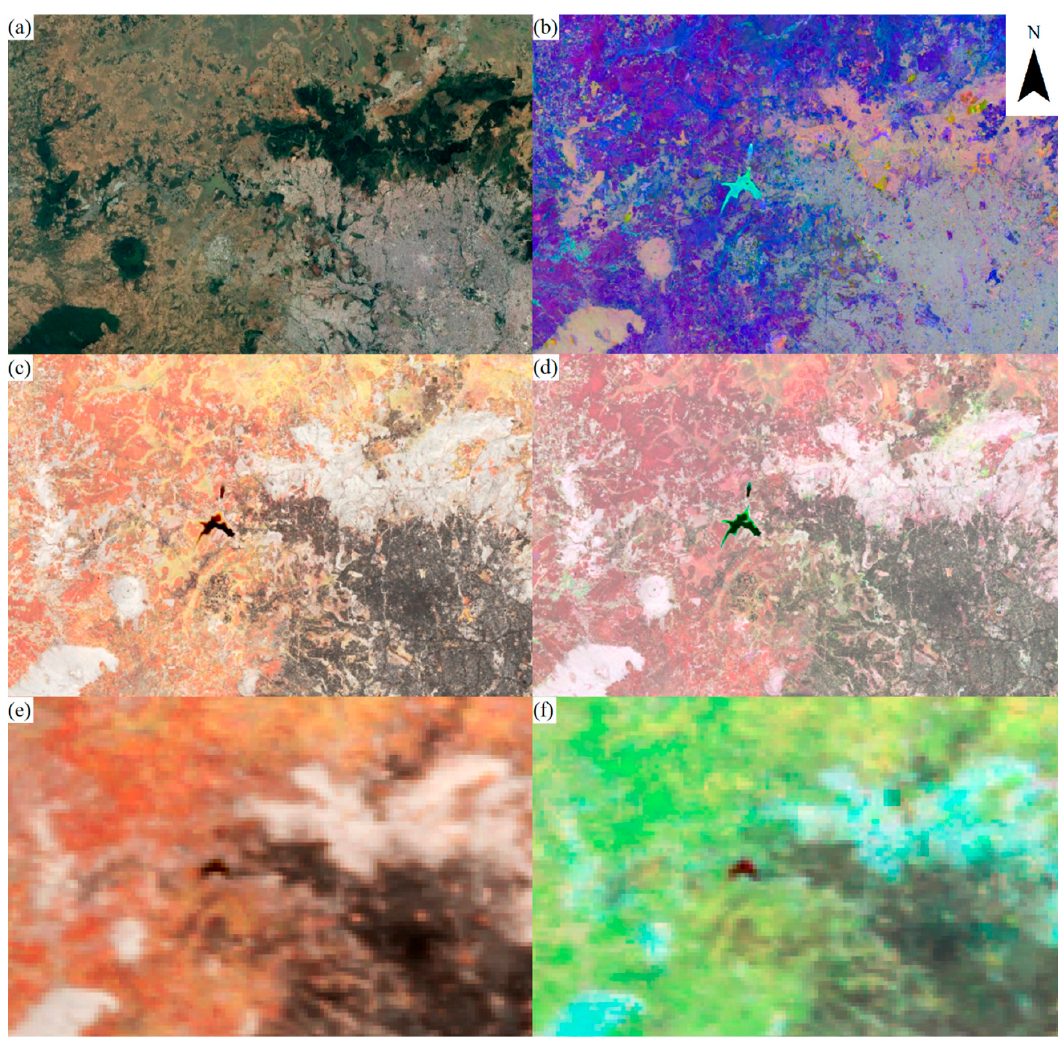
Figure 2. Visualization of multi-temporal image composites for Addis Ababa for: ( a ) high-resolution imagery from Google Earth Engine (GEE); ( b ) Landsat Normalized Difference Vegetation Index (NDVI) sinusoidal model coefficients, Red green blue (RGB): a 4 , a 3 , a 2 (see Equation (2));( c ) Landsat PDF composite, RGB: 95%, 75%, 50% of NDI 4 , i.e., NDVI; ( d ) Landsat sequential composite, RGB: median NDI 4 , i.e., NDVI, from periods 4,2,1 (see Section 2.3.2); ( e ) MODIS PDF composite, RGB: 95%, 75%, 50% of NDVI; and ( f ) MODIS sequential composite, RGB: median NDVI for June 2016, October 2016, and January 2017.